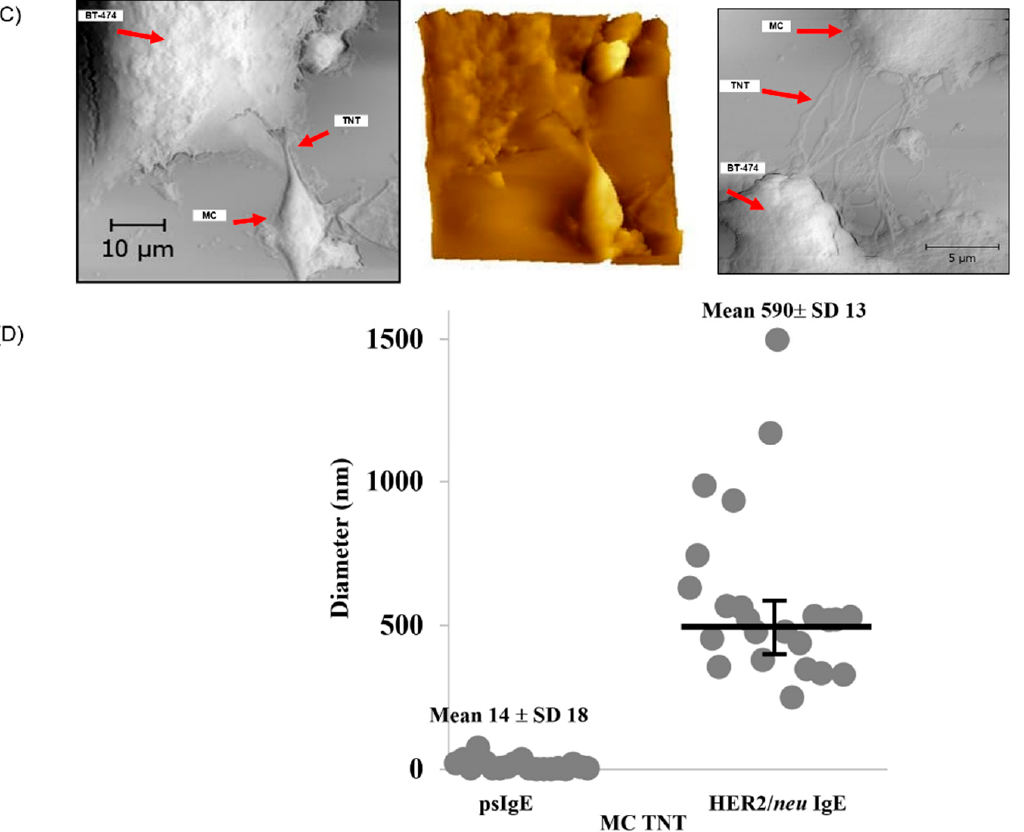
Figure 1. MC binding to HER2/ neu -positive cancer cells is IgE dependent. Note. ADMC (1.5 × 10 5 ) were sensitized without ( A ) or with ( B ) human anti-HER2/ neu IgE, washed and incubated with BT- 474 cells for 72 h. Cells were then processed for SEM imaging. ( C ) For further characterization of TnT formation, HER2/ neu IgE-sensitized MCs were co-cultured with BT-474 cells, and the preparation steps were done for AFM imaging. ( D ) Mean s.e.m. distribution of TnT diameters from images ± between HER2/ neu IgE-sensitized ADMC and BT-474 cells. n = 25 TnT.